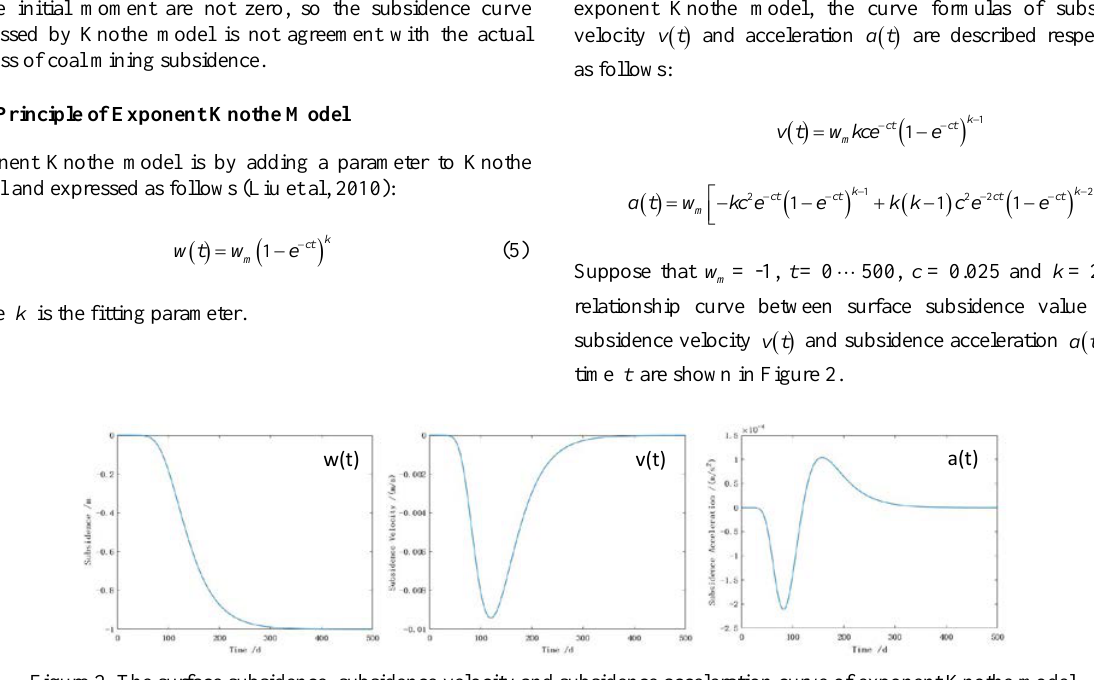
Figure 2. The surface subsidence, subsidence velocity and subsidence acceleration curve of exponent Knothe